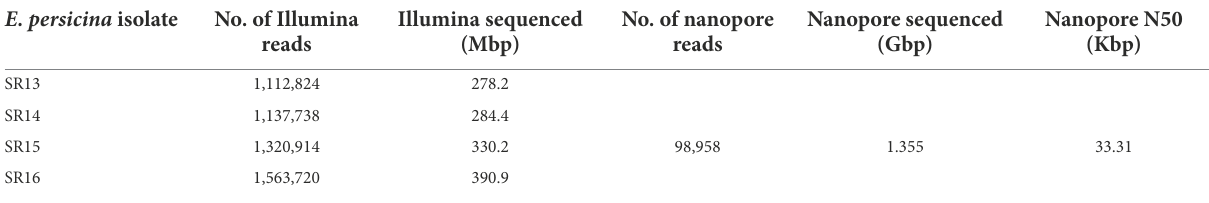
TABLE 2 Genome sequencing raw read